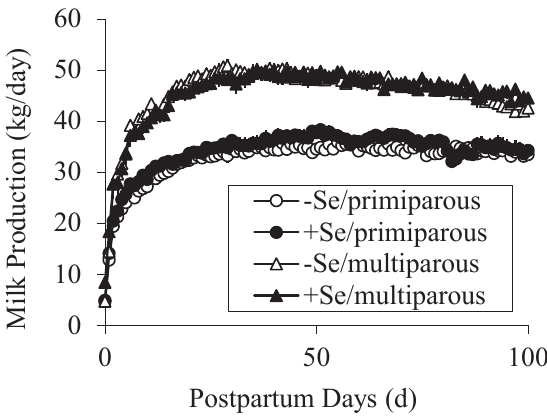
Figure 2. Profile of the milk production (kg/d) (mean±standard error of the mean) of prrimiparous (-Se: n = 8, +Se: n = 7) and multiparous (-Se: n = 9, +Se: n = 10) cows between 0 to 100 days after calving. Data of milk production was collected every days at milking parlor. Figure 3. Changes in the plasma Se concentration (ppb) relative to parturition Table 3. Effects of Se supplementation on plasma biochemical parameters